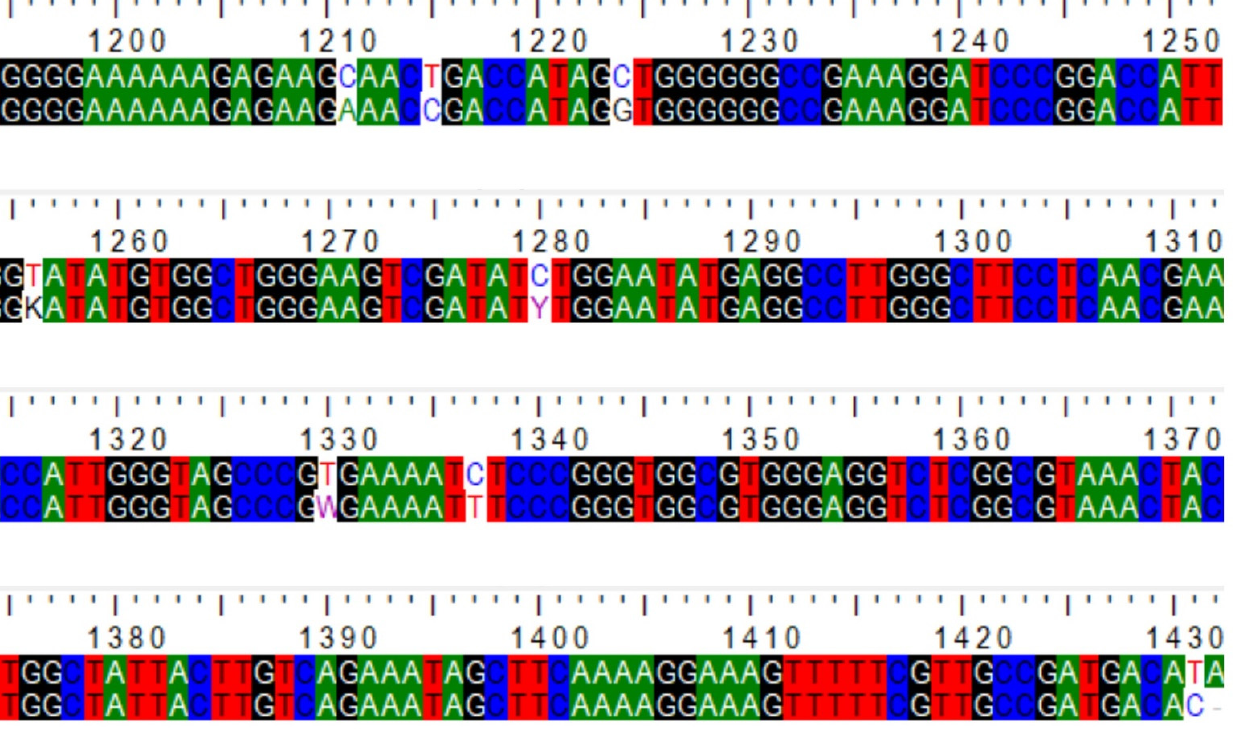
nucleic acids (DNA) without cDNA synthesis. No amplification was observed, confirming that flavivirus genome was not integrated into the mosquitoes’ genome. These results also supported the hypothesis that mosquitoes in our study were infected with a novel mos- quito-specific flavivirus. 3.4. Confirmation That Mosquitoes Were Infected by a Mosquito Flavivirus To confirm that the mosquitoes in our pools were infected by a mosquito flavivirus, a TaqMan assay was designed to amplify specifically mosquito virus from the extracted nucleic acid pools. All the 242 Pan-Flavivirus-positive pool were positive by mosquito virus-specific TaqMan assay and had similar sequence. These results suggest that the col- lected pools of mosquitoes in our study were probably carrying a candidate novel mos- quito-specific flavivirus. 4. Discussion We conducted a screening of mosquito-borne flaviviruses among the vector in Mak- kah city, during and after the 2016 Hajj. Most of the collected mosquito vectors were Ae. aegypti with evidence of the presence of Culex and Anopheles species. Using our screening methodology, no known flaviviruses were detected including ZIKV. There was evidence that the mosquito vector was infected with a probably novel insect flavivirus. These results suggest that ZIKV was not circulating in Makkah during the study period and that there is no evidence that ZIKV was introduced to KSA through the 2016 Hajj mass gathering.